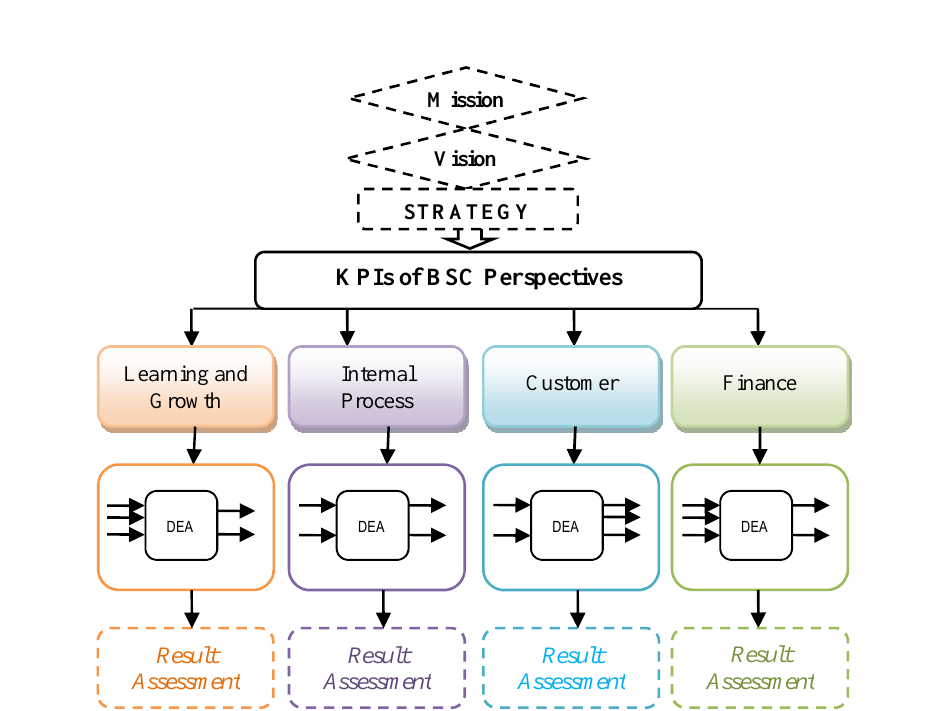
Figure 5 – Proposed integrated model of DEA and BSC (Aryanezhada, Najafib, Farkousha,